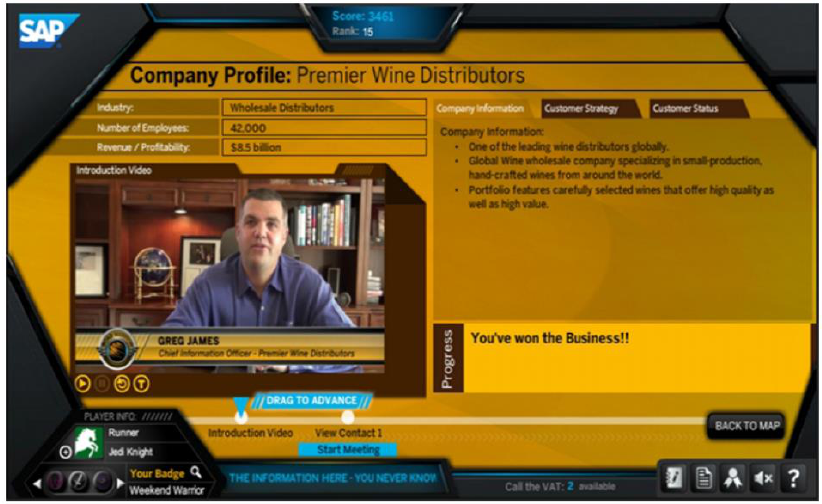
Fig. 2. User Interface of SAP Roadwarrior